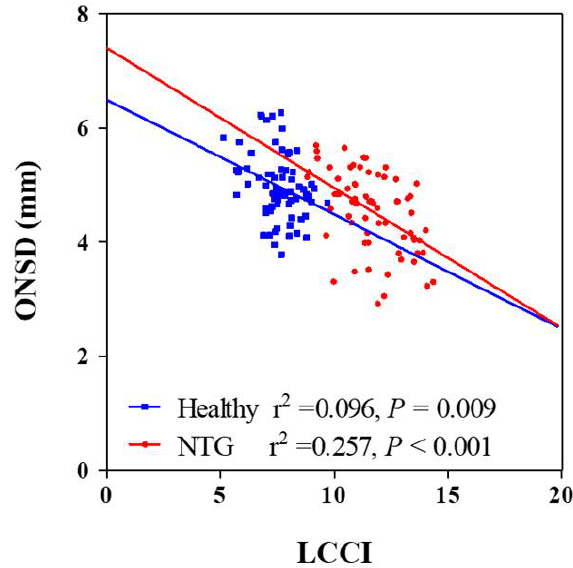
Figure 2. Scatterplots showing the relationship between lamina cribrosa curvature index and clinical parameters. Solid lines represent trend lines.